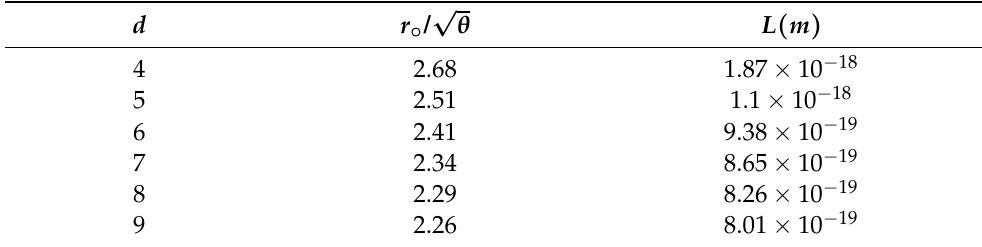
Table 2. Lower bound on length of extra